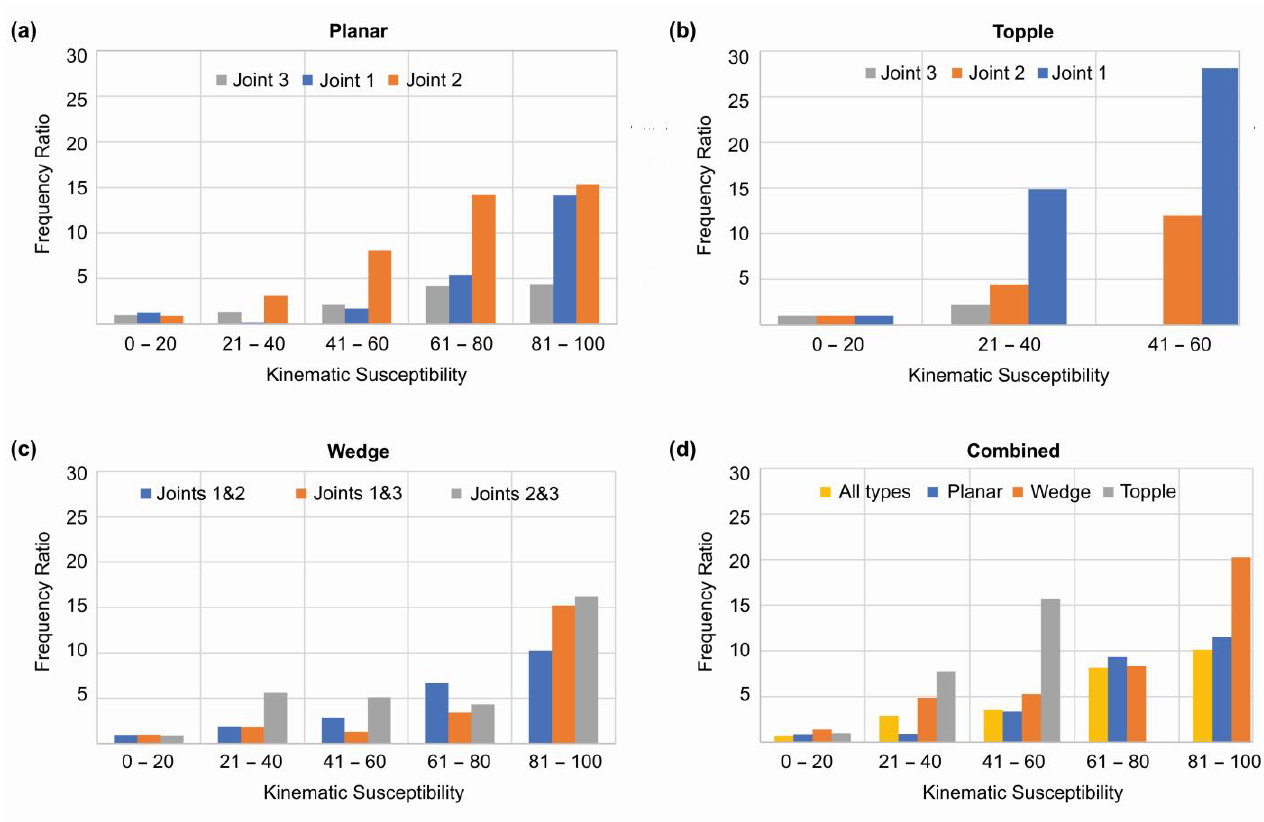
Figure 12. Frequency ratio (FR) for different joint and intersection sets in each mode of kinematic failure: ( a ) planar: the higher FR of joint 2 represents its dominance in creating planar failures; ( b ) topple: joint 1 is responsible for maximum flexural topple failures; ( c ) wedge: failure along joints 1 and 3 intersection is dominant for the slopes with susceptibility less than 80 and failures along joints 2 and 3 intersection are dominant for slopes with susceptibility more than 80; ( d ) FR comparison for failures due to different modes of failure suggests that wedge failure is the dominant type of failure followed by planar and topple.